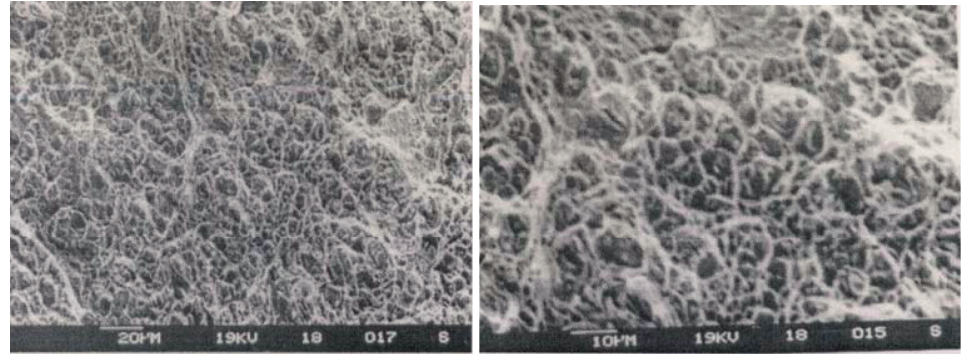
Figure 6. Fractographs of sheet specimens (tensile tested at room temperature), showing fine dimples. Test Temperature, ı C